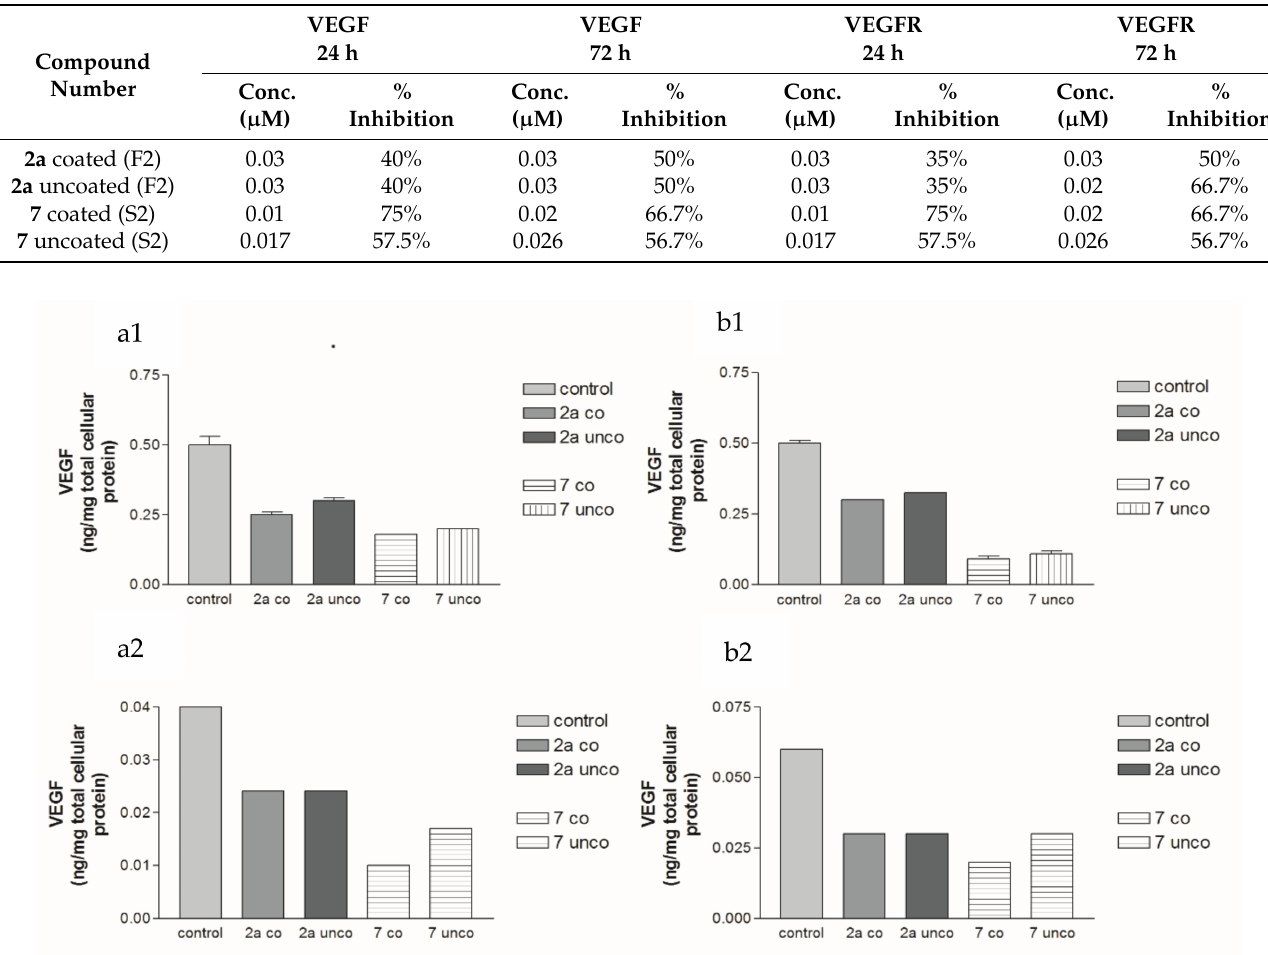
Figure 21. Effects of 2a - and 7 -loaded niosomes (F2 and S2), either being coated with TPGS versus the uncoated ones, on VEGF protein expression level (ng/mg tissue protein) in HEPG2 and MCF-7, where ( a1 , a2 ) at 24 h and ( b1 , b2 ) 72 h, all therapies were provided for 3 successive days. Results are given as mean ± S.E.M. 2a co: 2a -coated (F2), 2a unco: 2a uncoated (F2), 7 co: 7 -coated (S2), 7 unco: 7 uncoated